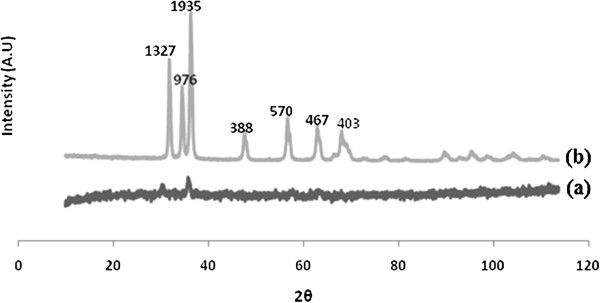
XRD pattern of (a): modified Fe3O4 and (b): Fe3O4/ZnO core/shell.